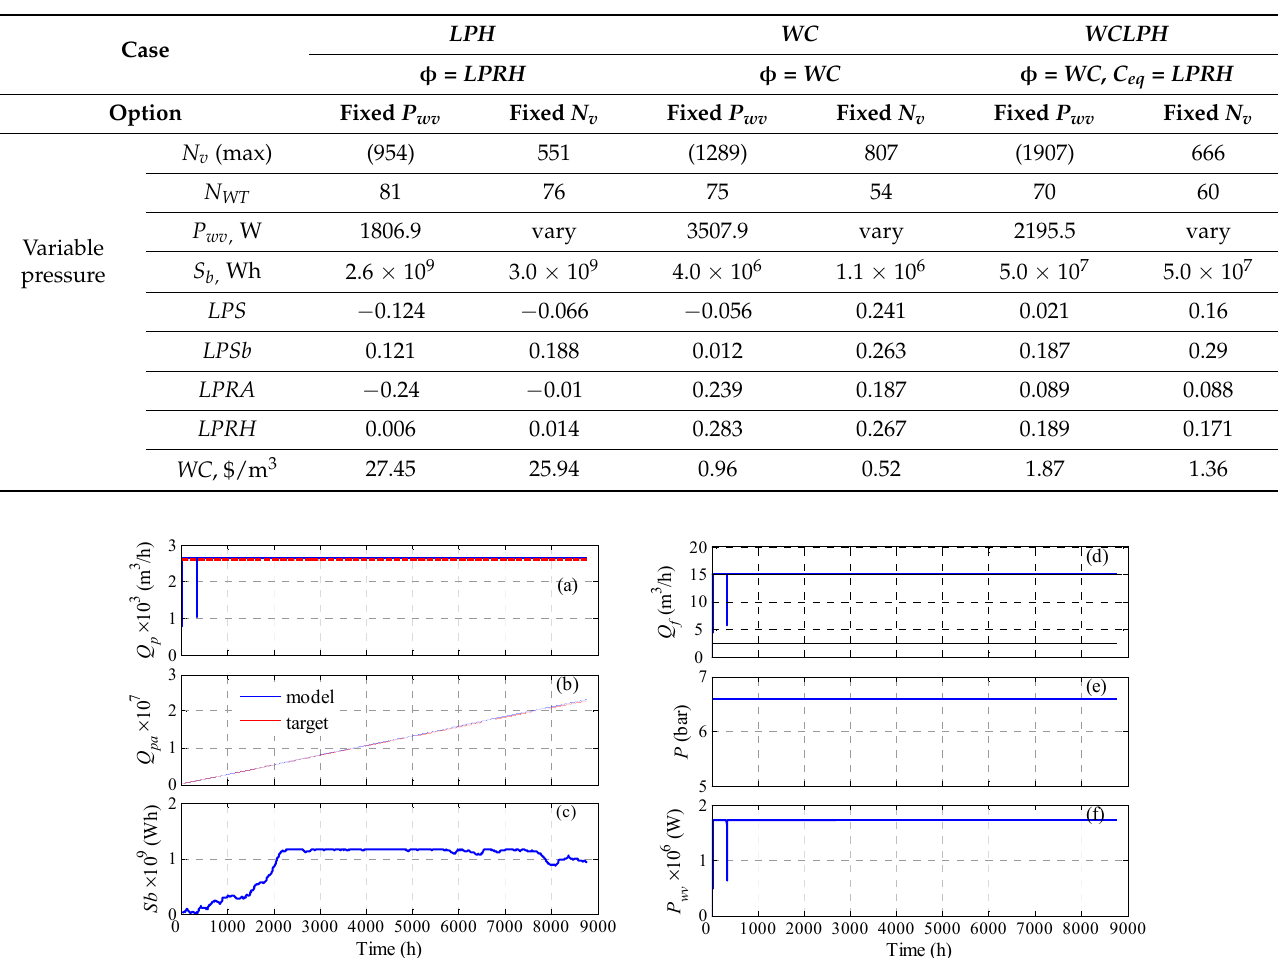
Figure 7. Optimization results for the case of fixed pressure and optimized N WT , N v , and N b for satisfying the hourly production rate via energy storage; Q p : hourly production rate, Q pa : accumulative production, Sb : Battery storage capacity; Q f : hourly fee flow rate, P : feed pressure; P wv : supplied power per vessel.